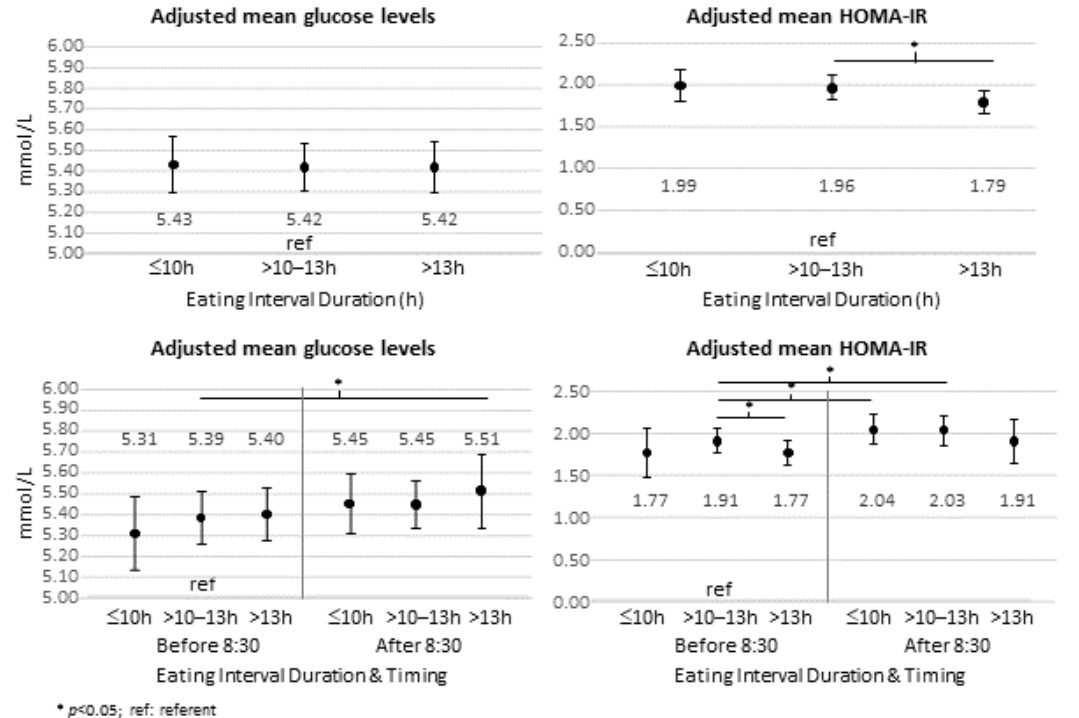
Figure 1. Adjusted mean glucose ( left ) and insulin resistance (HOMA-IR) ( right ) by eating interval duration (top two panels) and by eating interval groups categorized by start time at/before or after 8:30 a.m. (bottom two panels). Estimated means for each group are adjusted for age, gender, BMI, education level, race/ethnicity, total kcal/day, sleep duration, alcohol use, smoking, diabetes, and cohort and then back transformed.